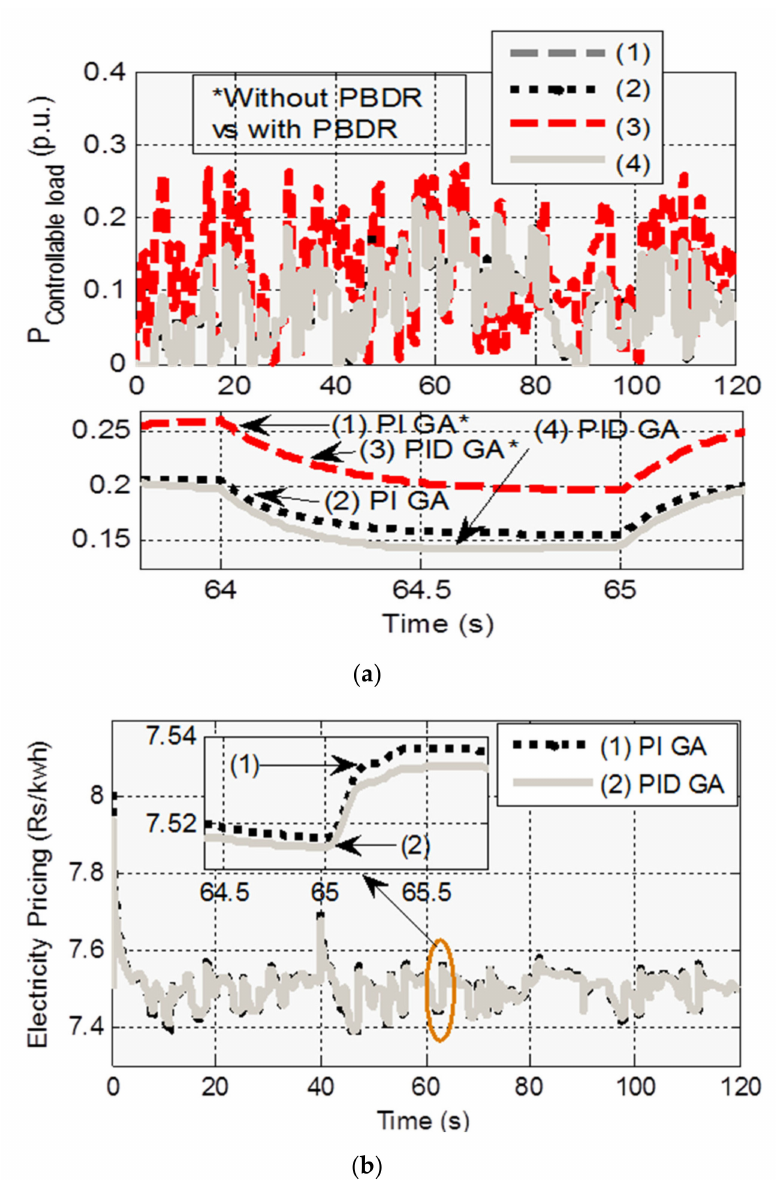
Figure 4. ( a ) Controllable thermostatic loads, without and with PBDR. ( b ) Change in electricity pricing, without and with